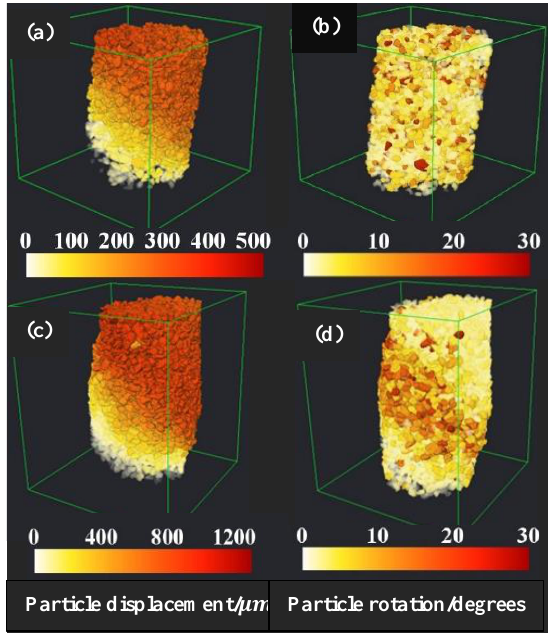
Fig.2 Displacements (a) and rotations (b) of sand grains in LBS-R during the last shear increment; displacements (c) and rotations (d) of sand grains in LBS during the last shear increment